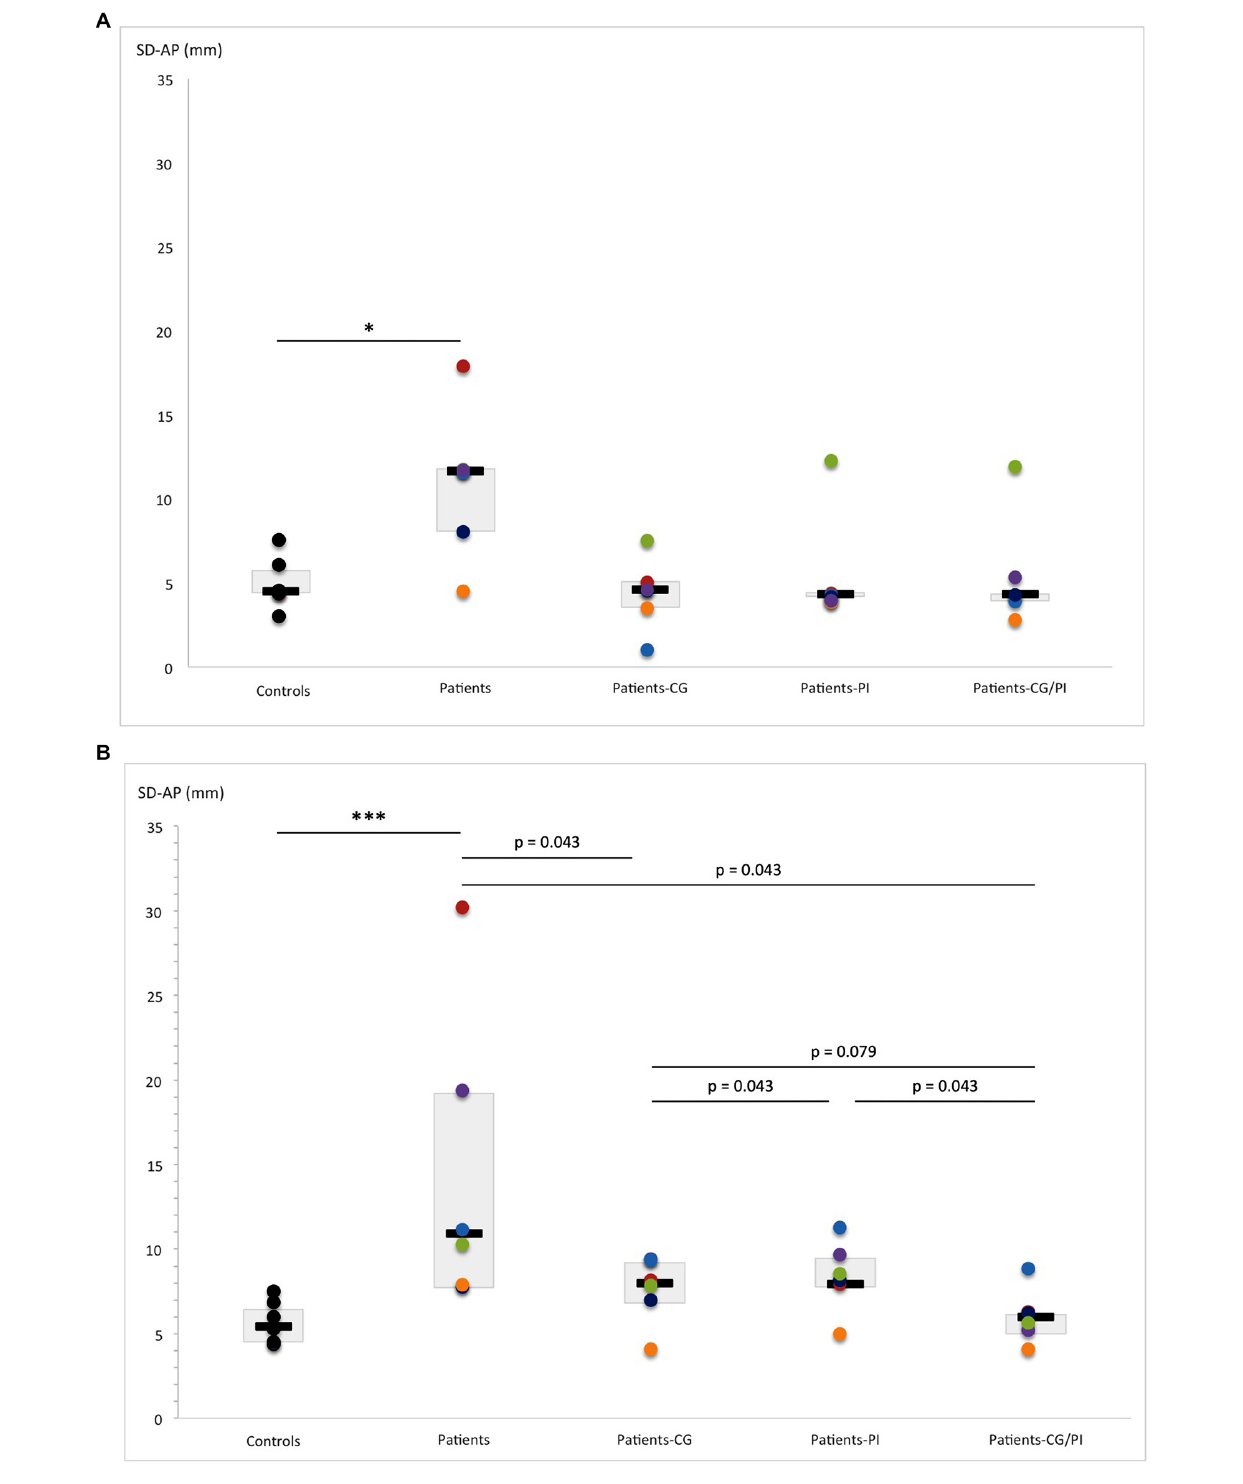
Frontiers in Human Neuroscience | www.frontiersin.org